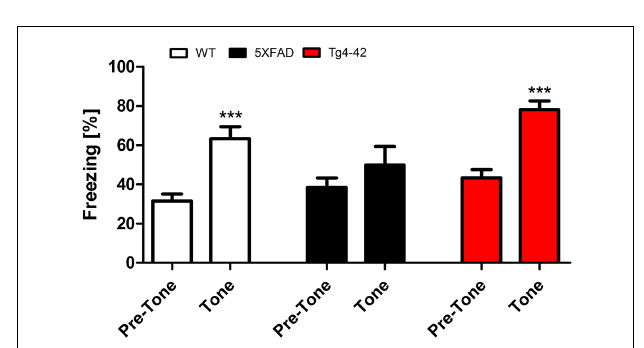
FIGURE 4 | Impaired tone conditioning in 5XFAD mice . Aged 5XFAD, Tg4–42, andWT mice at 12months of age were trained with a CS/US pairing for tone fear conditioning ( n = 11–13). Mice were placed in an altered fear conditioning chamber 48h post training and tested for freezing during tone presentation (CS).WT andTg4–42 mice shock froze significantly more during tone presentation compared to the training trial. In contrast, 5XFAD mice did not associate the tone with the received foot-shock as freezing was not significantly different between the training and the tone trial. CS, conditioned stimulus; US, unconditioned stimulus. Freezing: unpaired t -test; ** p < 0.001.